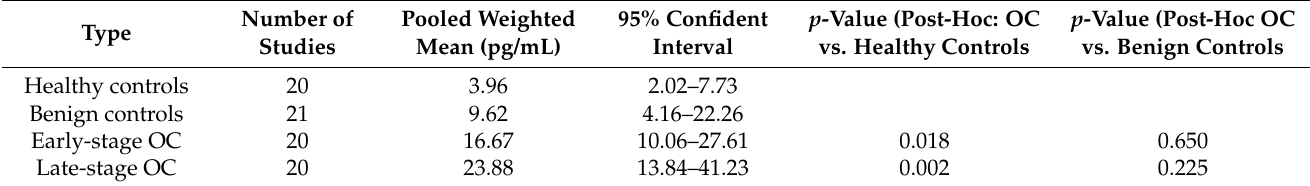
Figure 1. The PRISMA flowchart of the article selection. The steps of our study selection are depicted as a flowchart following PRISMA recommendations. Table 1. The pooled weighted means of IL6 levels in serum/plasma with 95%